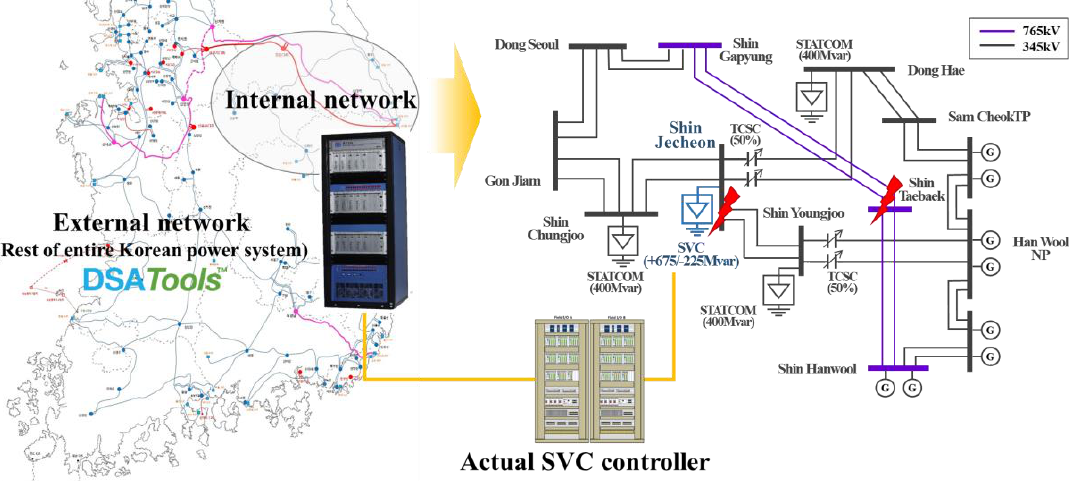
Figure 7. Case study map of Shin-Jecheon SVC HILS-DPT using RTHS.